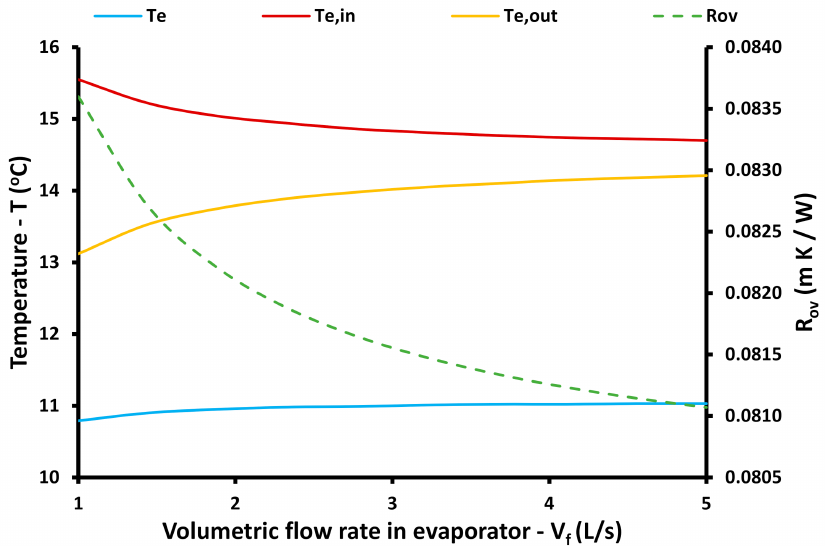
Figure 11. The impact of the volumetric flow rate in the evaporator on the evaporator temperature levels and on the overall resistance.